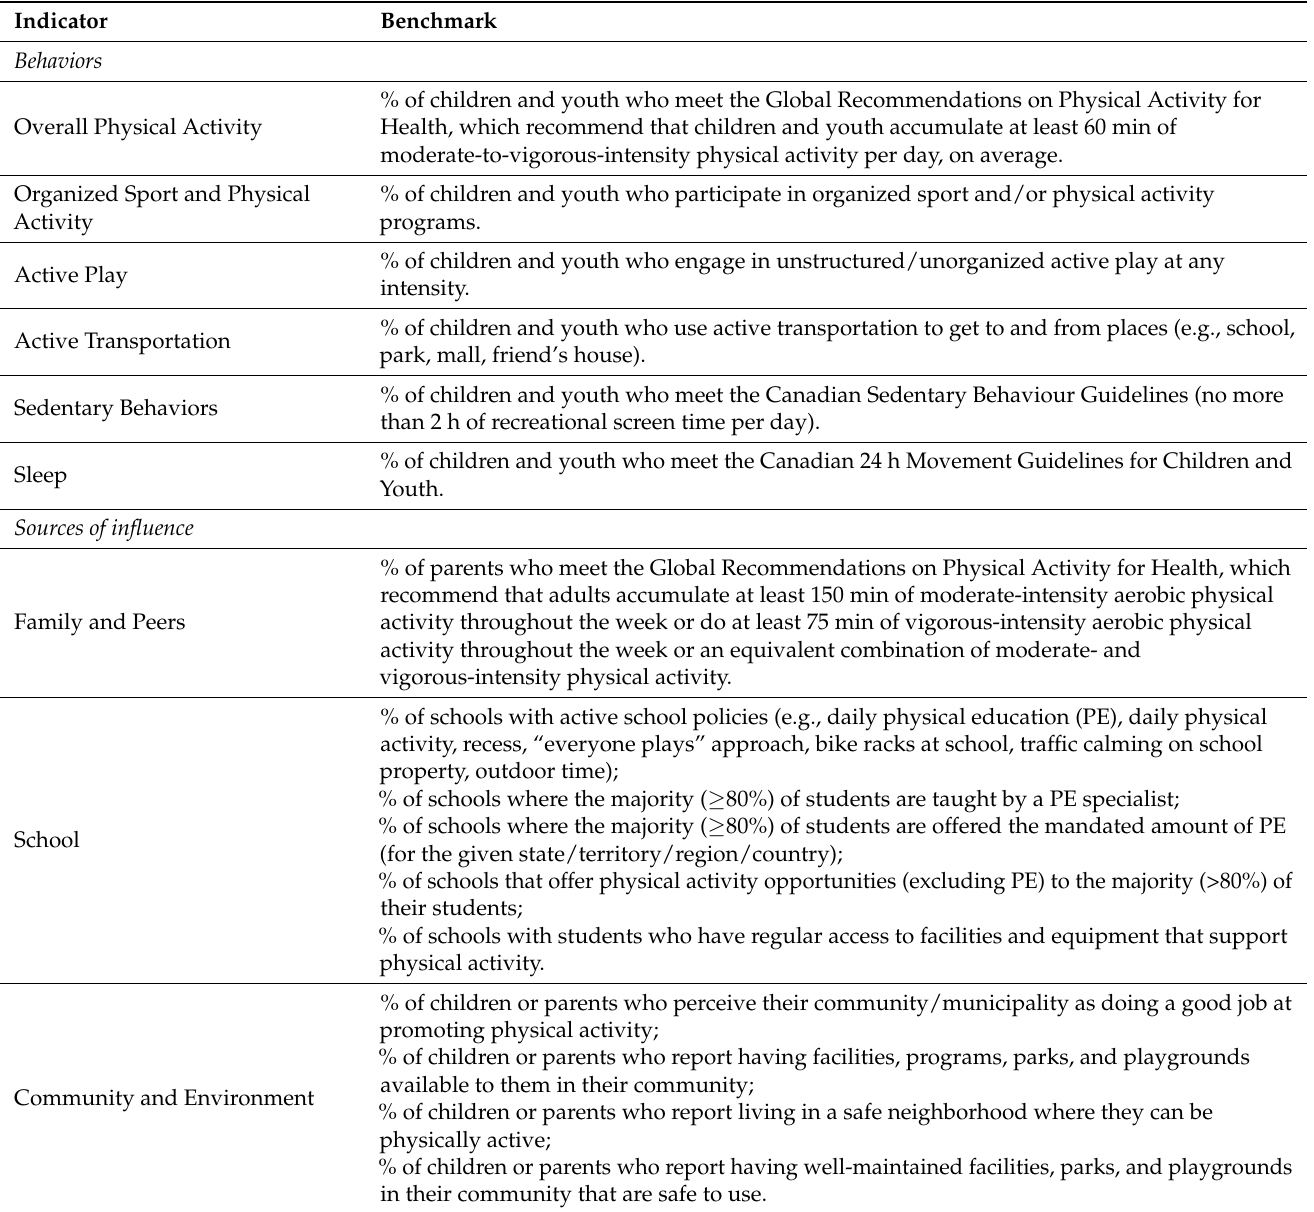
Table 1. Investigated indicator and benchmark used for the development of the Report Card Brazil